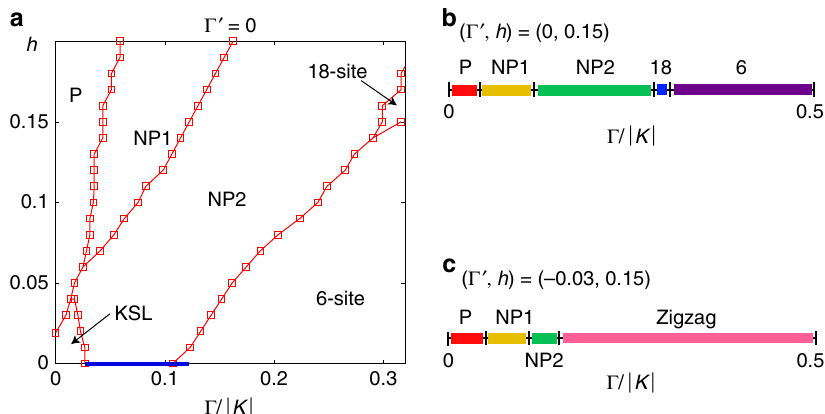
Fig. 4 Comparison to the phase diagram of the K (cid:3) Γ model. a Phase diagram at Γ 0 ¼ 0 as functions of Γ = j K j and h . NP1 and NP2 phases are larger than those at Γ 0 ¼ (cid:3) 0 : 03 since the zig-zag phase is less dominant. Complexed magnetic phases appear when Γ = j K j ≳ 0 : 3 and h ≳ 0 : 15. The blue solid line at h ¼ 0 denotes a ferromagnetic phase (see text for details). Larger Γ phase diagrams at b ( Γ 0 ; h ) ¼ ð 0 ; 0 : 15 Þ and c ( Γ 0 ; h ) ¼ ð(cid:3) 0 : 03 ; 0 : 15 Þ . The information on numerical parameters is given in the “ Methods ” section.